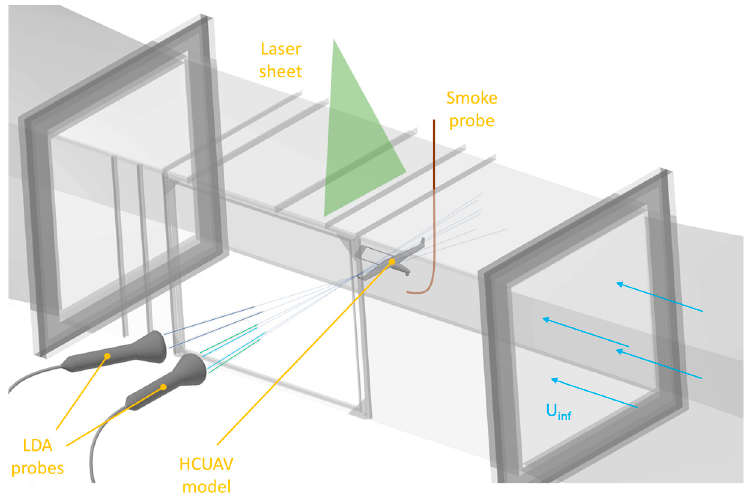
Figure 3. Schematic of the experimental setup and arrangement of the measurement devices inside the test section.